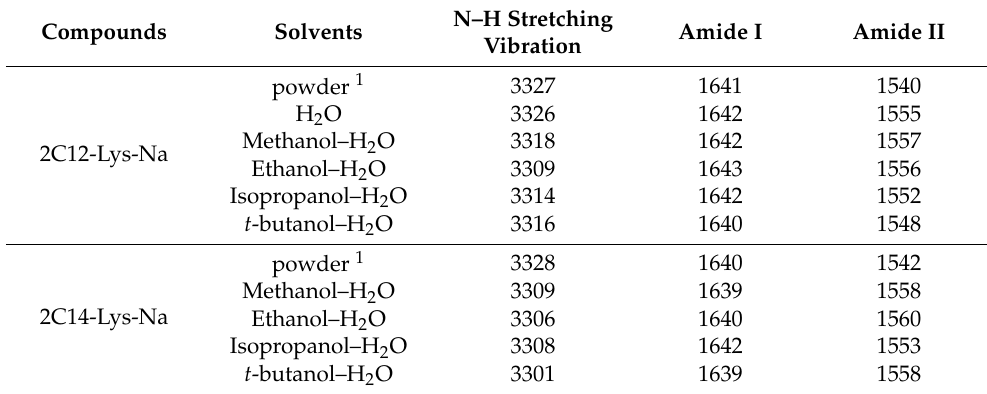
Table 2. FT-IR data (cm − 1 ) of 2C12-Lys-Na, 2C14-Lys-Na, and dried gels formed in this study. N–H Stretching Compounds Solvents Amide I Amide II Vibration powder 1 3327 2C12-Lys-Na